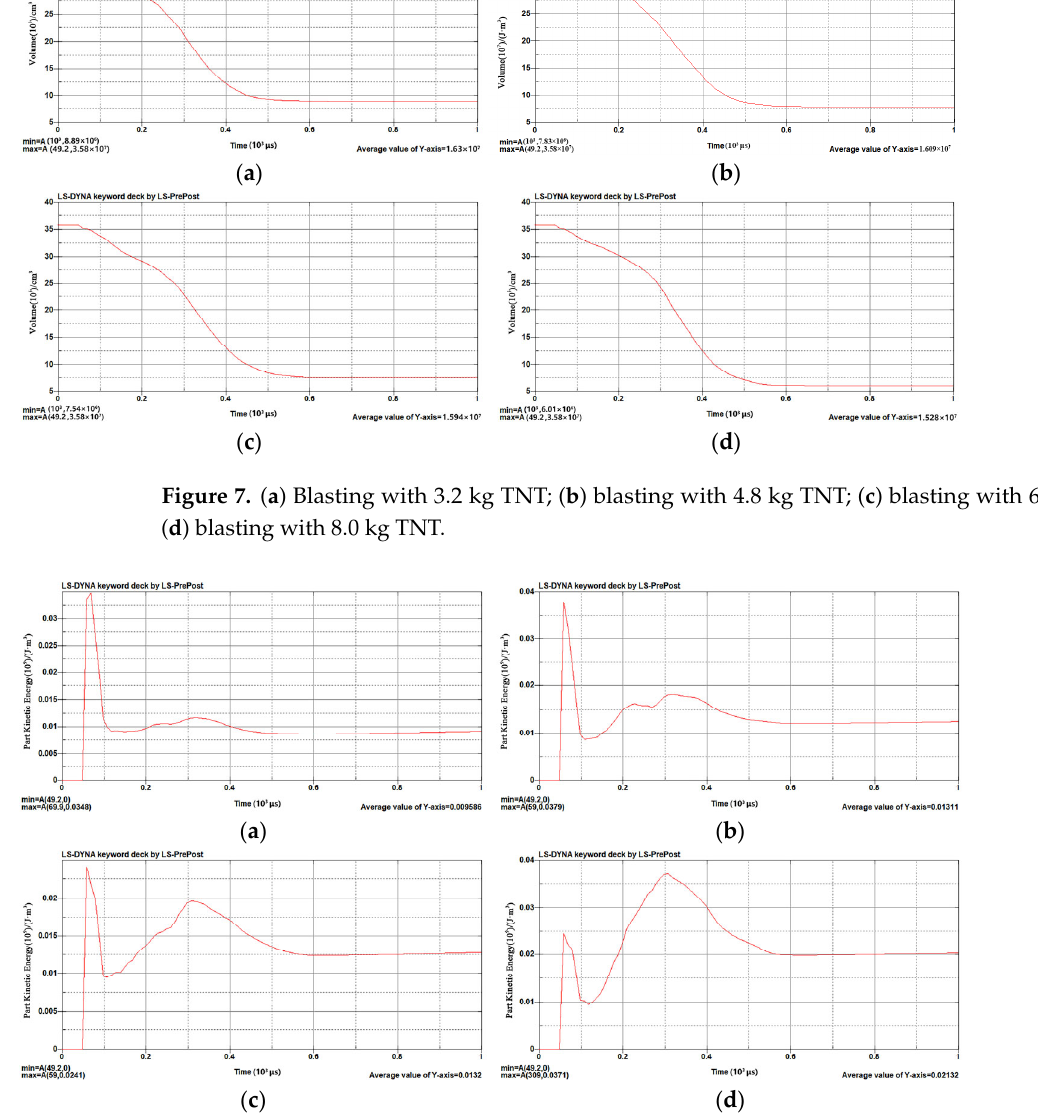
Figure 8. ( a ) Blasting with 3.2 kg TNT; ( b ) blasting with 4.8 kg TNT; ( c ) blasting with 6.4 kg TNT; ( d ) blasting with 8.0 kg TNT. The relationships between explosive mass and ice blasting volume, maximum pres ‐ sure at the end, instantaneous kinetic energy, and average kinetic energy are shown in Table 6. Table 6. Relationship between ice thickness and ice blasting volume, maximum pressure at the end, instantaneous kinetic energy, and average kinetic energy.